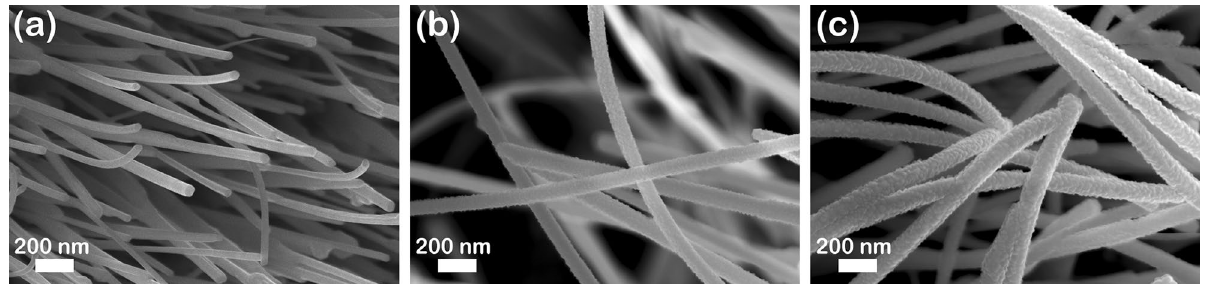
Figure 4. FESEM images at higher magnification of: ( a ) CuO_MIE, ( b ) CuO–ZnO_MIE_1 and ( c ) CuO–ZnO_